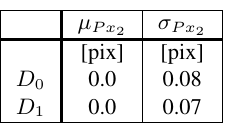
Table 4: Oregon; µ Px , σ Px – the mean and standard deviation 2 2 of the residual parallax computed for along-track stereo pair. Figure 8: Accuracy as a function of weighting parameters pds rot ,